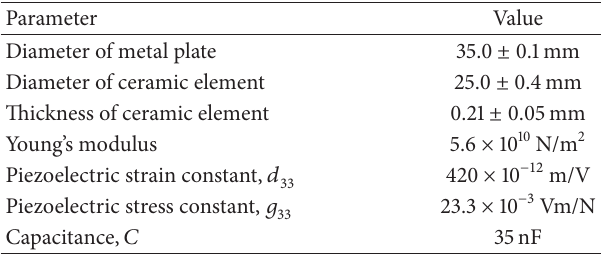
Table 1: Specifications of the round piezoelectric